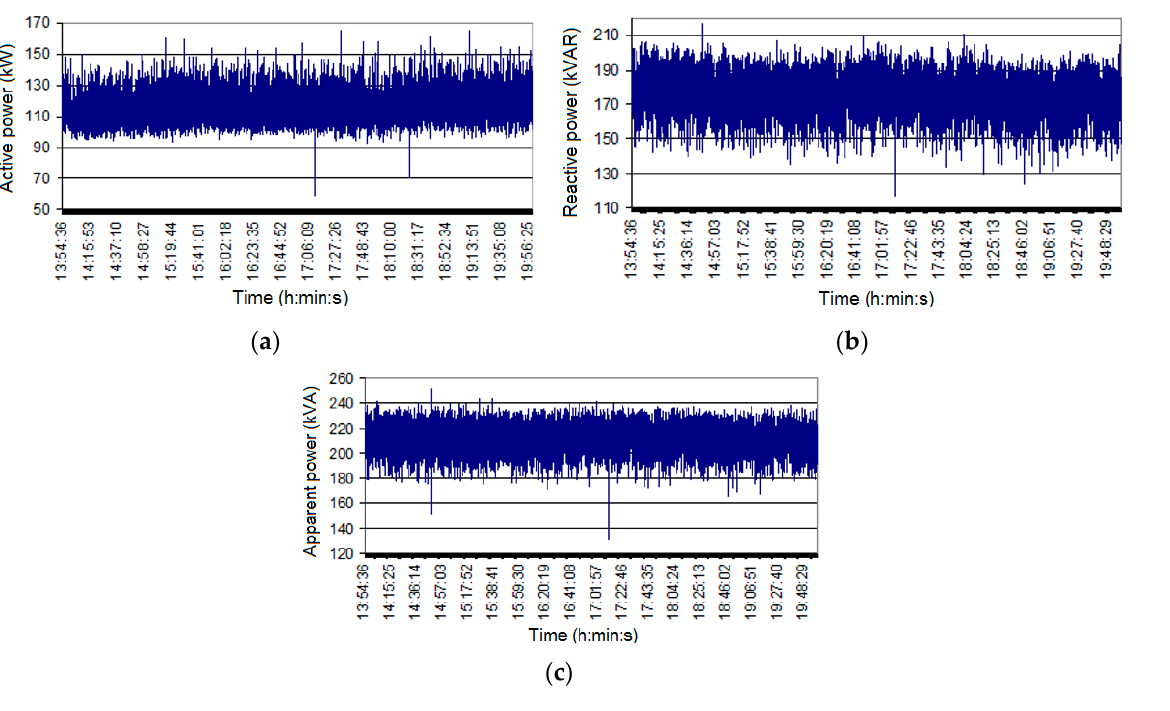
Figure 21. Power measurement: ( a ) total active power; ( b) total reactive power; ( c ) total apparent power.